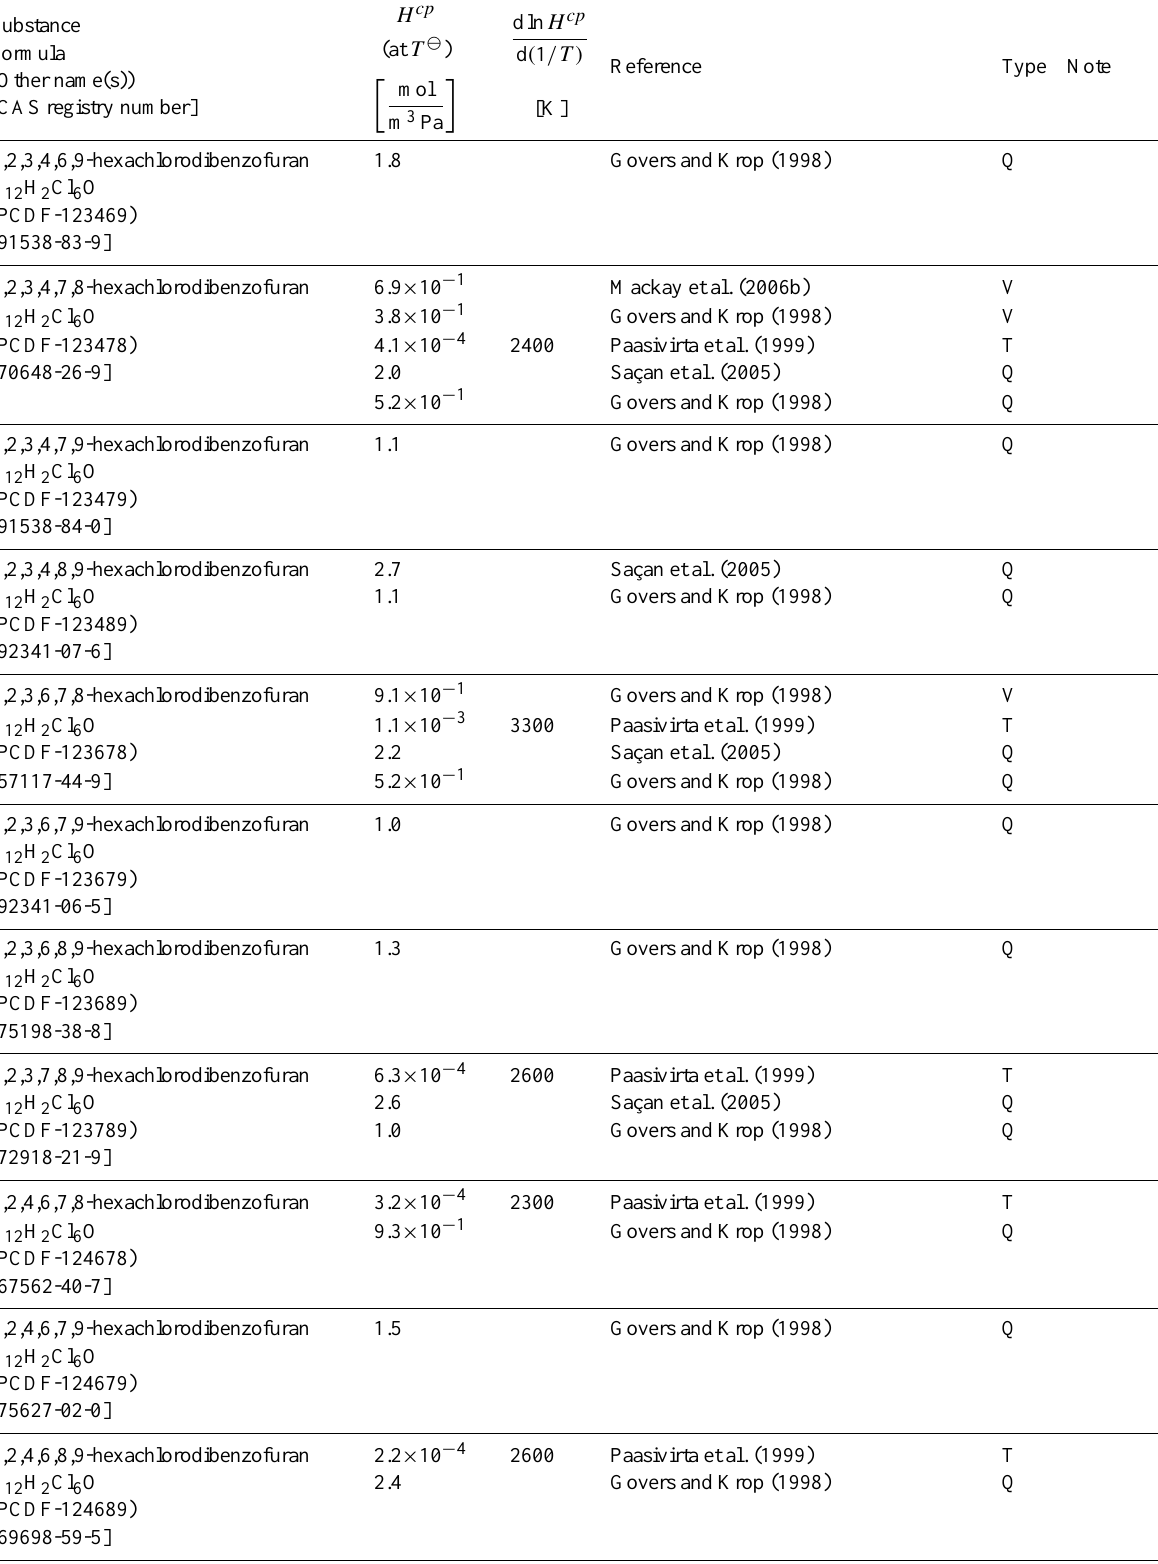
Table 6: Henry’s law constants for water as solvent